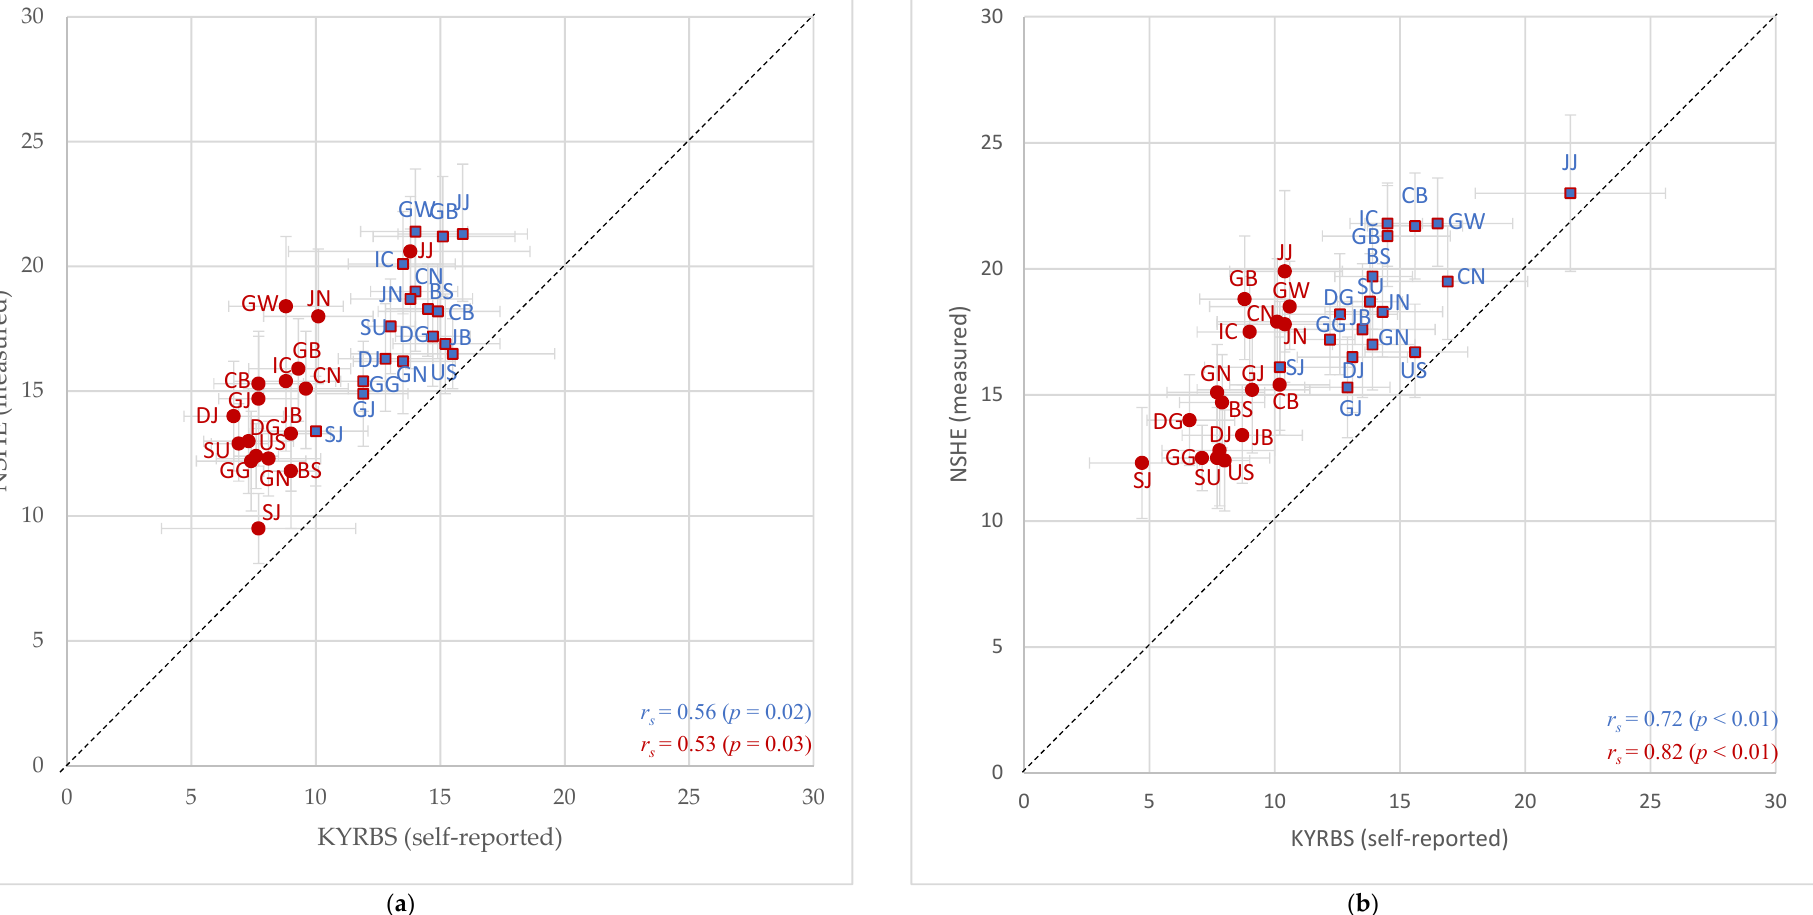
Figure 3. Simple correlation graphs for regional obesity prevalence estimated from the KYRBS (self-reported) and NSHE (directly measured). ( a ) Comparisons of 2018 prevalence between the data sources; ( b ) comparisons of 2019 prevalence between the data sources. Dots represent weighted percentage and gray lines indicate 95% confidence intervals. Values for boys are presented with blue (square) dots and those for girls are presented with red (circle) dots. Abbreviations: SU, Seoul; BS, Busan; DG, Daegu; IC, Incheon; GJ, Gwangju; DJ, Daejeon; US, Ulsan; SJ, Sejong; GG, Gyeonggi; GW, Gangwon; CB, Chungbuk; CN, Chungnam; JB, Jeonbuk; JN, Jeonnam; GB, Gyeongbuk; GN, Gyeongnam; JJ,